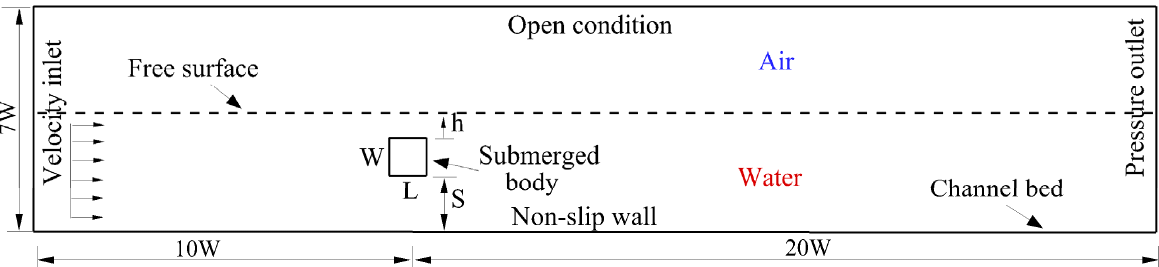
Figure 1. Computational model of the free surface flow around a submerged body.